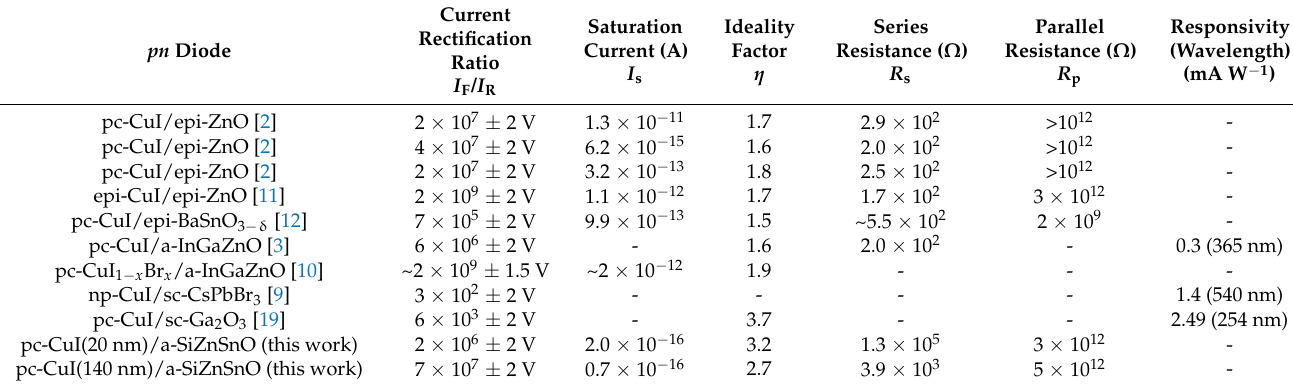
Current Saturation Ideality Series Rectification Current (A) Factor Resistance ( Ω ) Ratio I s I F / I R